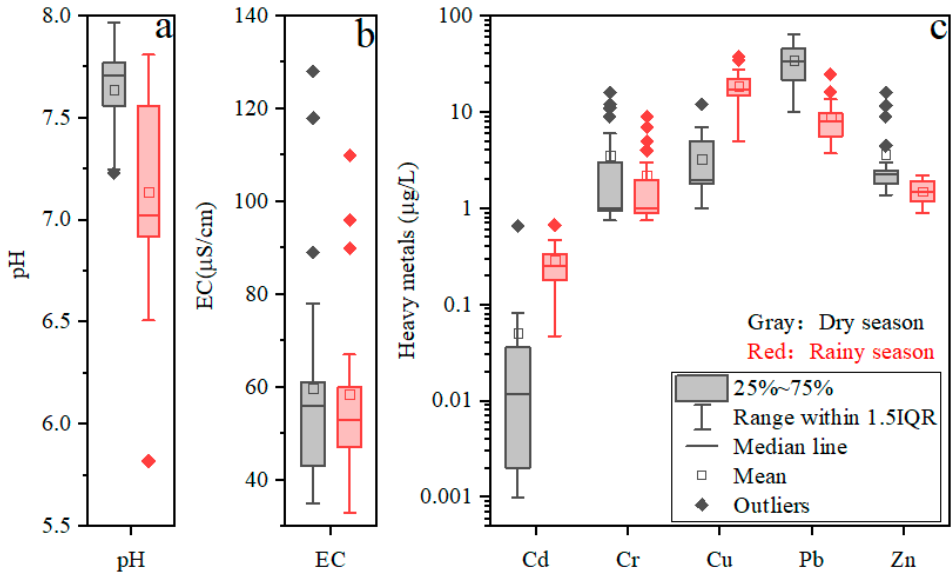
Figure 2. The statistical summary of ( a ) pH, ( b ) EC values, and ( c ) heavy metal concentrations of the Fuhe River water.